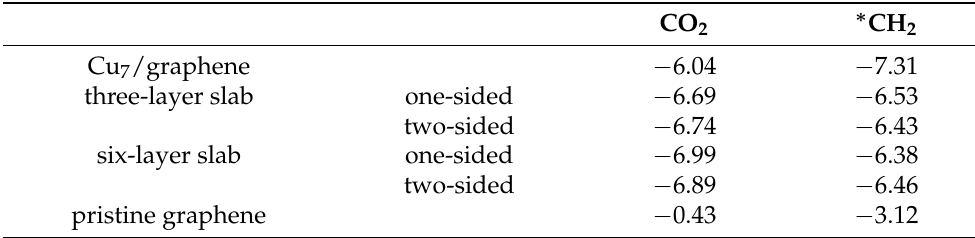
Calculated adsorption energies (eV) of CO 2 molecule and ∗ CH 2 intermediate on Cu 7 /graphene nanostructure, Cu (111) surface, represented as three-layer and six-layer slab, and pristine graphene layer with 5 × 5